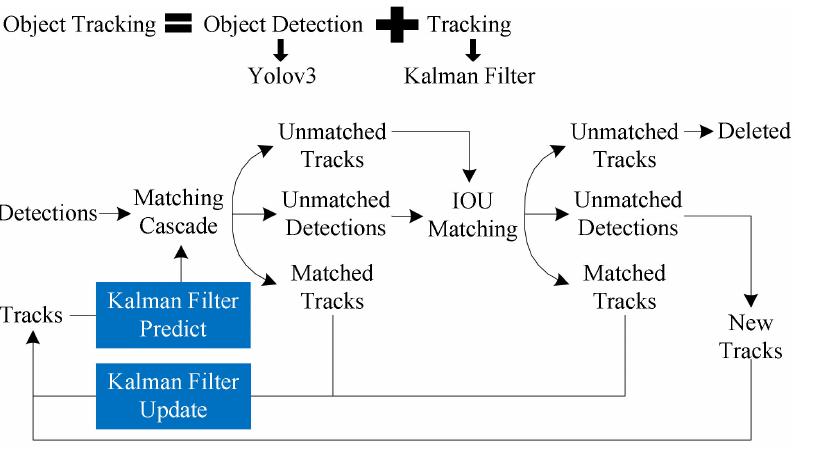
Figure 3. Flow chart of human